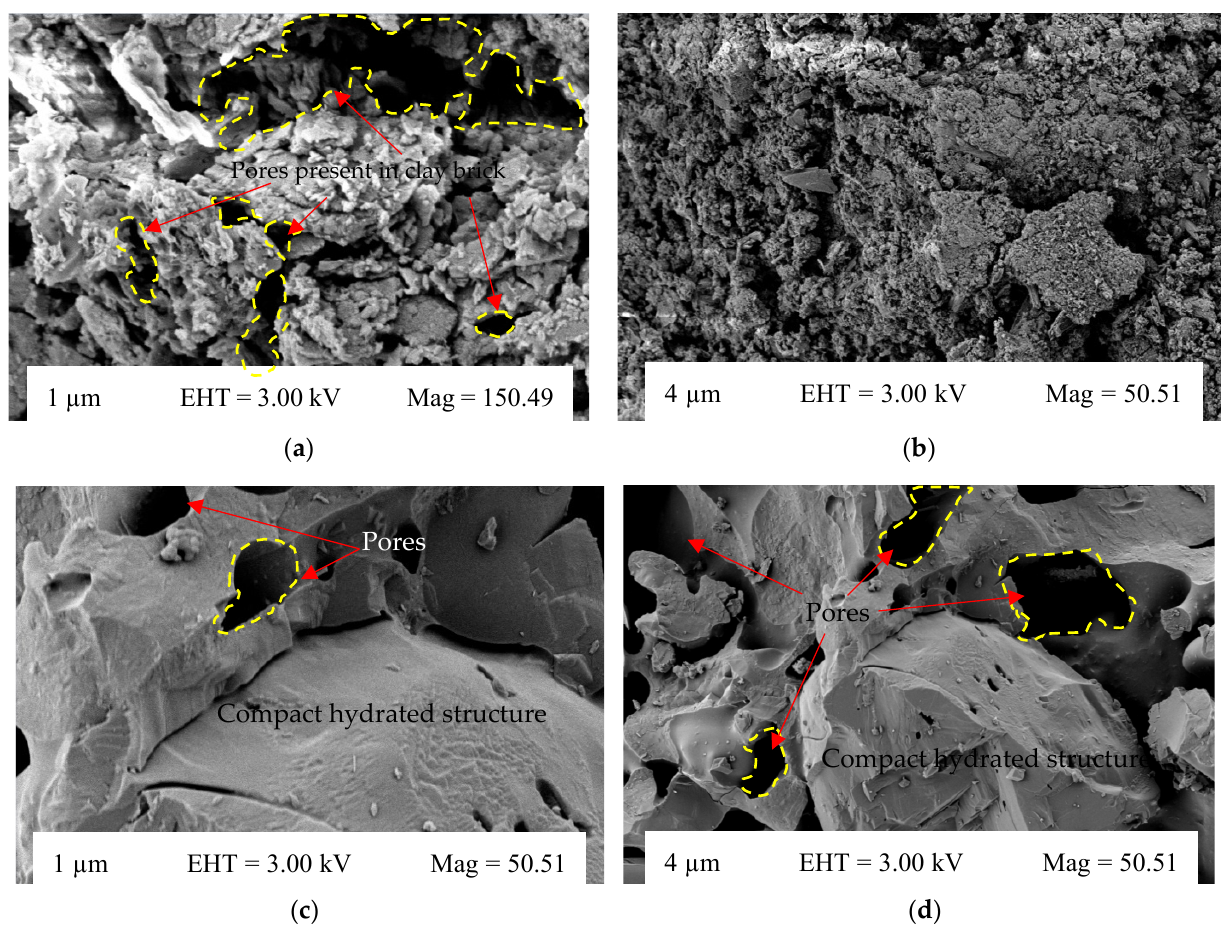
Figure 20. Scanning electron microscopy (SEM). ( a ) SEM of a burnt clay brick, ( b ) SEM of a burnt clay brick, ( c ) SEM of a coal ash brick, ( d ) SEM of a coal ash brick